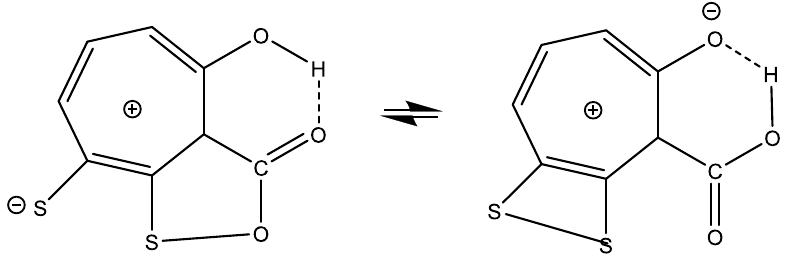
Figure 24. Tautomerism of Thiotropocin. From Ref. [97].